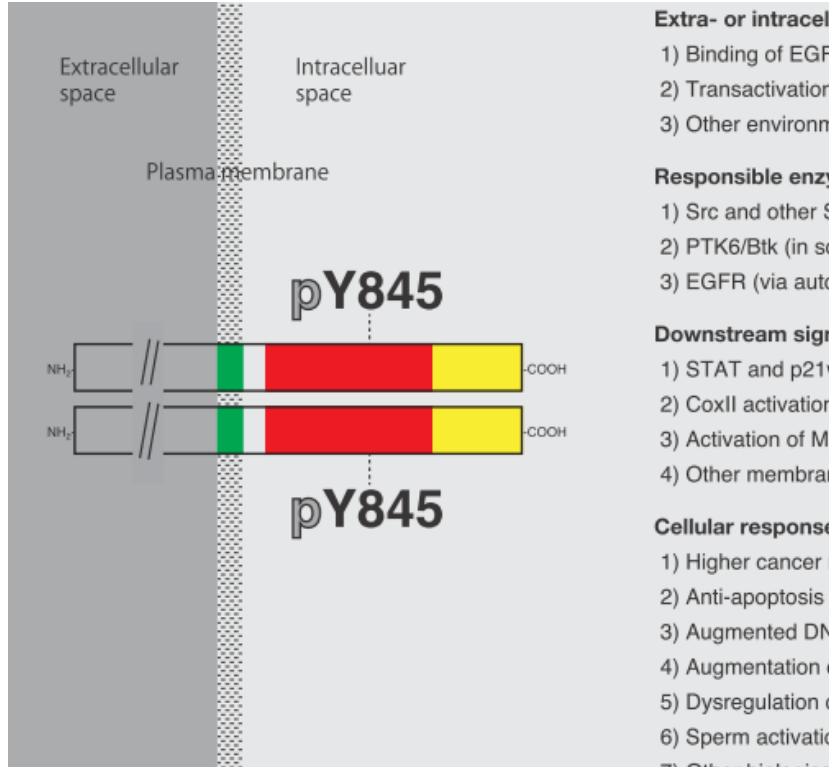
Figure 2. A sequence of events associated with Y845 phosphorylation of EGFR. Phosphorylation of EGFR on Y845 is usually catalyzed by Src and other Src family PTKs, and in some cases, is mediated by a non-Src family PTK or autophosphorylation of EGFR. The Y845 phosphorylation modulates a variety of cellular functions through the activation of several downstream events. It can also be used as a diagnostic marker of cancer treatments and for other applications that harness the phospho-Y845 signal into an antibody-, peptide-, or some other materials-based biological mimetics, as described in the main